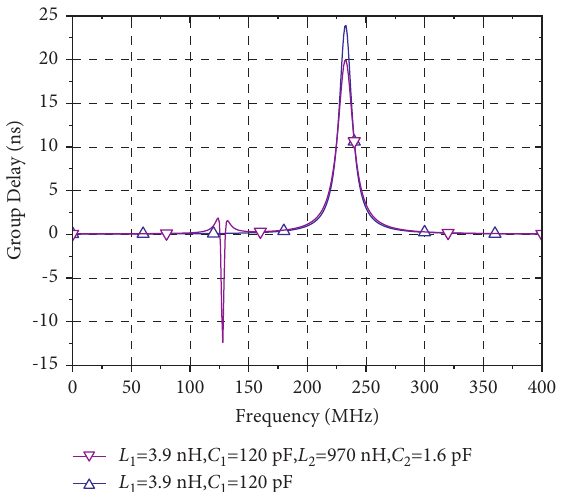
Figure 3: Group delay of the band-stop filter and band-pass negative group delay band-stop filter. Table 1: Element values and performance indexes of the band-stop filter with different L